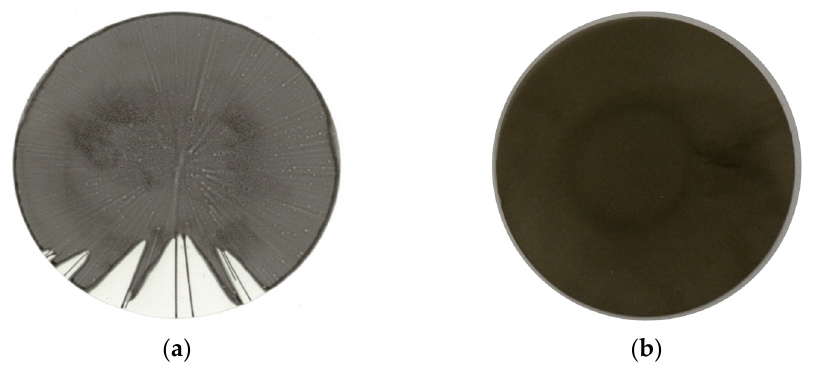
Figure 8. PI ‐ based layer from solution with 12.7 wt.% polymer concentration, prepared at an insufficient coating speed of 1000 rpm for 150 s ( a ) compared to a membrane with improved surface coverage ( b ).